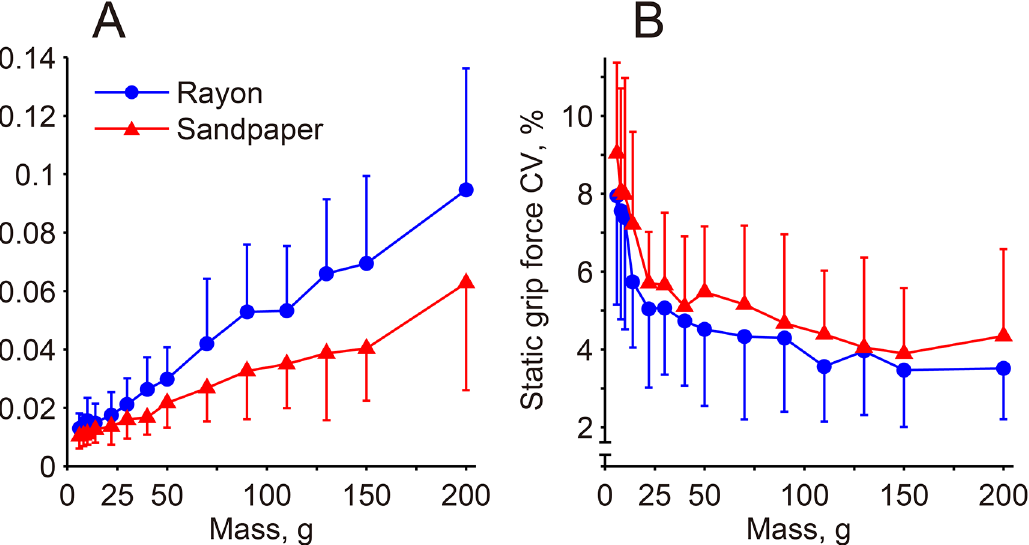
Fig 4. Within-trial variability of static grip force expressed by standard deviation (A) and coefficient of variation (B). The data represent the mean and standard deviation (vertical bars) values of 17